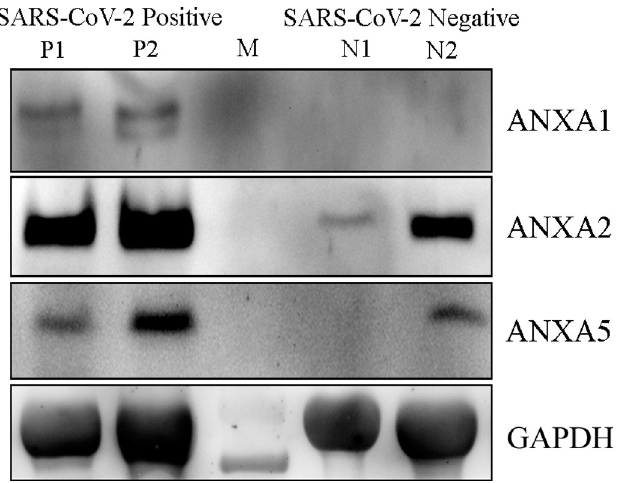
Fig 6. Analysis of Annexins. Western blot analysis for ANXA1, ANXA2 and ANXA5 proteins in infected and non- infected NOPS samples. P1 and P2 indicates the SARS-CoV-2 positive samples; M denotes the protein molecular weight standard and N1 and N2 denotes the SARS-CoV-2 negative